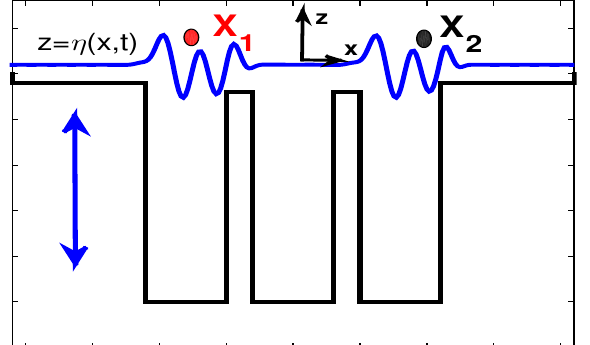
Figure 1. This is a schematic representation of the fluid domain with 3 cavities. All cavities are of the same width and depth but do not need to be the same. The arrows indicate that the bath is vibrating vertically at a prescribed frequency ω 0 . Some simulations have one droplet, while others have two droplets confined in different cavities, as shown by the dots above the surface wave profile z = η ( x , t )